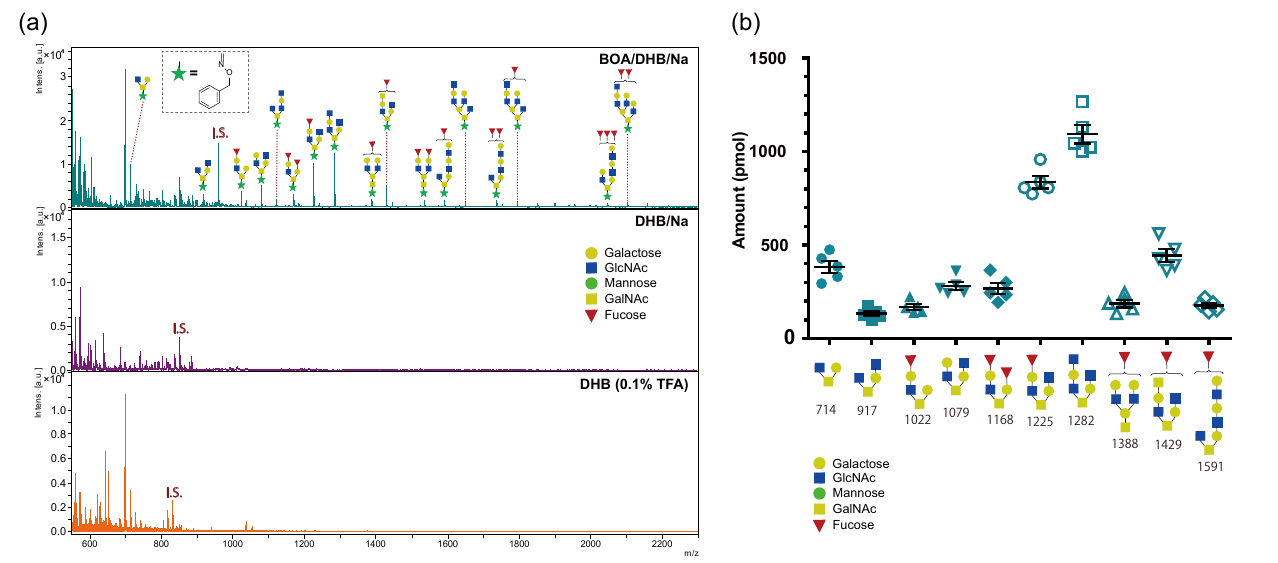
Figure 6. O -linked glycan profiles obtained from mucin from porcine stomach (MPS): ( a ) Represen- tative MALDI–TOFMS spectra with different matrices. Compositions of O -linked glycan structure were assigned by GlycoMod using experimental masses (mass tolerance is 0.2 Da), [15,20,21]. ( b ) Dot plot showing the amounts of the top 10 O -linked glycans in MPS (among five lots) analyzed with the BOA/DHB/Na matrix. I.S.: internal